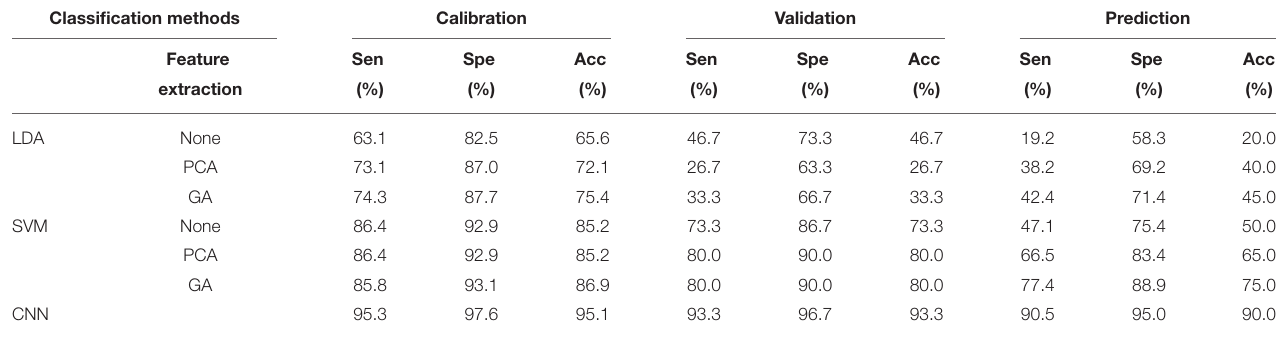
TABLE 2 | Comparison of model performance obtained with machine learning methods. Classification